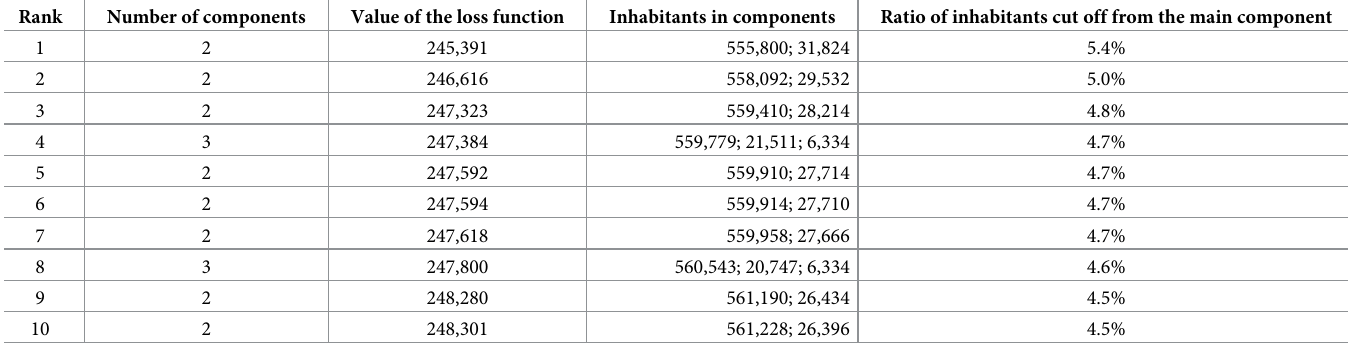
Table 3. The worst-case scenarios for the Zlı´n region.